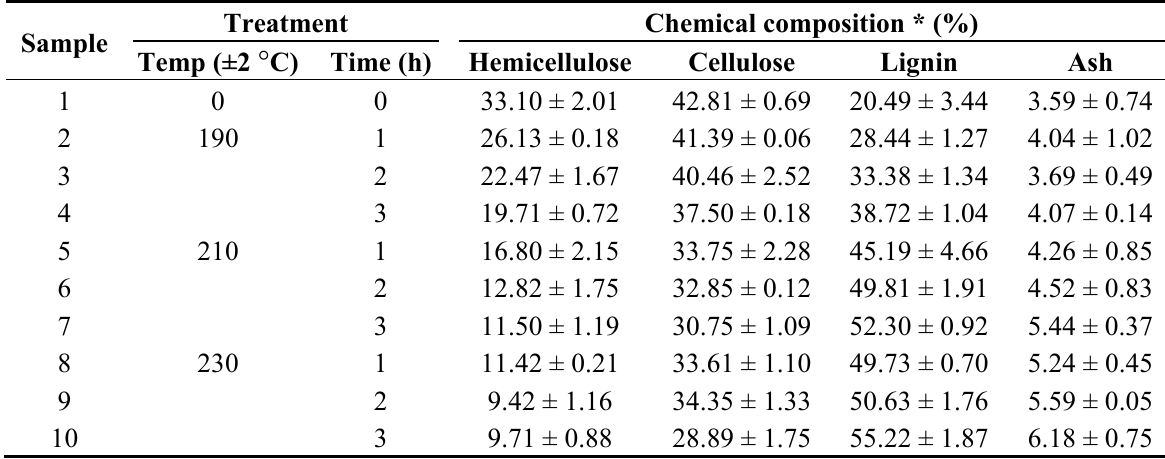
Table 1. Chemical composition of untreated and SHS-treated